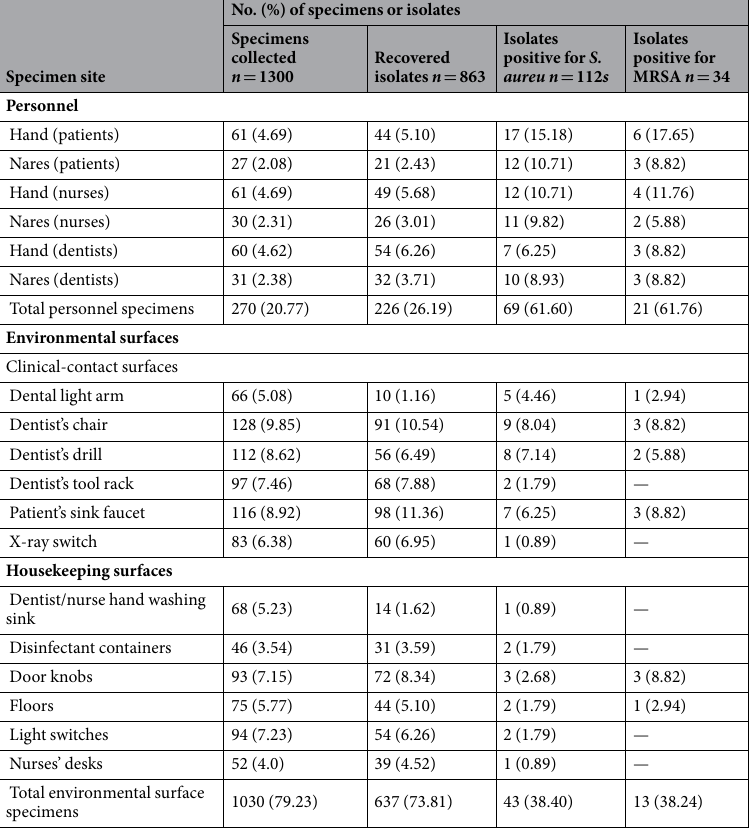
Table 1. Distribution of the recovered isolates by site of specimen. A minus sign ( − ) denotes the absence of an